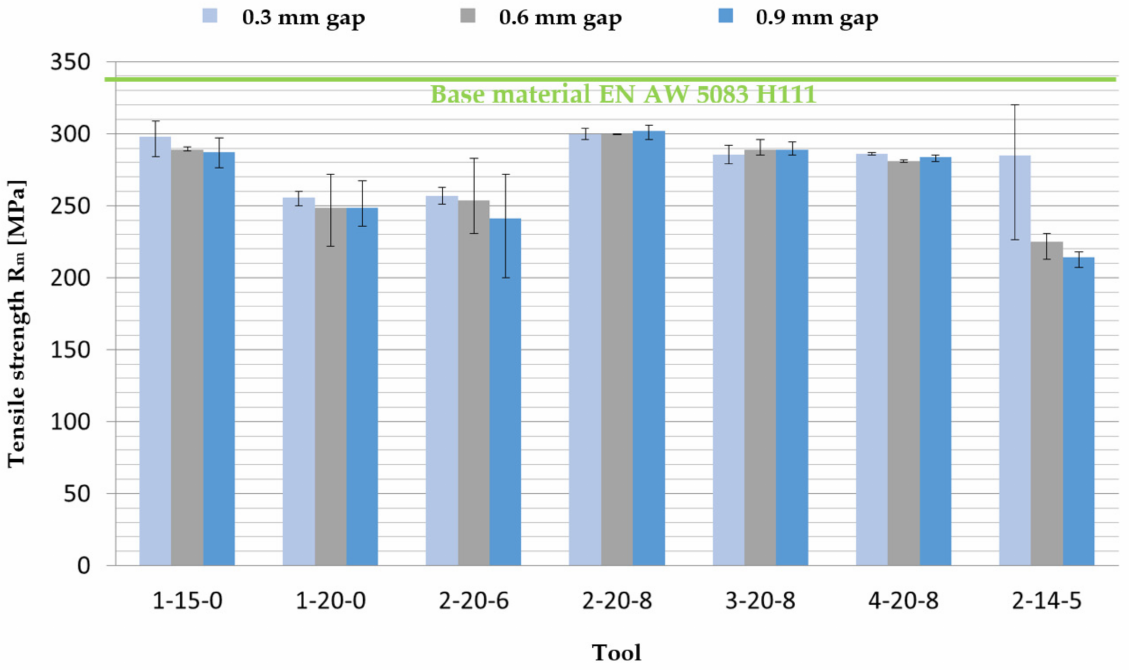
Figure 12. Comparison of the tensile strength of welded joints on material EN AW 5083